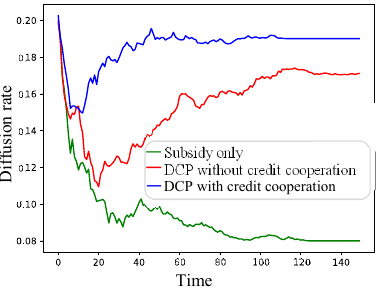
Figure 5. Results in small world network.